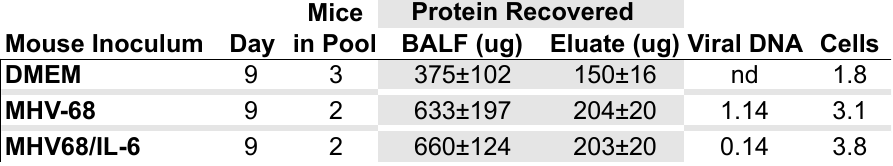
Figure 1. Analysis of bronchoalveolar lavage (BAL) fluid from murine herpesvirus-68 (MHV-68) infection of the mouse lung. ( A ) Overview of differential proteomics analysis of proteins induced in BAL by virus infection. Wild-type (WT) MHV-68 or MHV68/IL6 virus infection, BAL fluid processing, protein spot identification, and protein data analysis scheme. BAL fluid processing removed cells, immunoglobulins, excess albumin, and salts, enriching the recovered eluent for less-abundant proteins. ( B ) Collagen production in MHV-68 infection of the mouse lung is exacerbated by lytic expression of interleukin-6 (IL6). C57/BJ6 mice were mock infected with DMEM or infected intranasally with 5 × 10 5 pfu of WT MHV-68 or MHV68/IL6 virus. Type I collagen in BAL fluid in MHV-68 and MHV68/IL6 infection was measured at indicated times post-infection by Sircol assay; p -value of fold induction estimated from unpaired, 2-tailed t -test; error bars represent standard error on the mean (S.E.M.) ( C ) Characteristics of bronchoalveolar lavage (BAL) fluid. BAL fluid recovered 9 days post-infection (d.p.i.) from C57/BJ6 mice inoculated as above was processed to remove cells, salts, abundant serum proteins and immunoglobulins. Average protein concentration was measured by Bradford assay ( ± 1 s.d.); eluate exhibited significant differences ( p < 0.05, unpaired, 2-tailed t -test) between MHV-68 and DMEM and MHV68/IL6 and DMEM. Average viral DNA copy number (1 × 10 5 cp) in BAL in 3 mice for each condition measured by qPCR, and average mononuclear cellularity (1 × 10 5 cells) measured by trypan blue hemocytometry; differences not significant. IEF = isoelectric focusing.